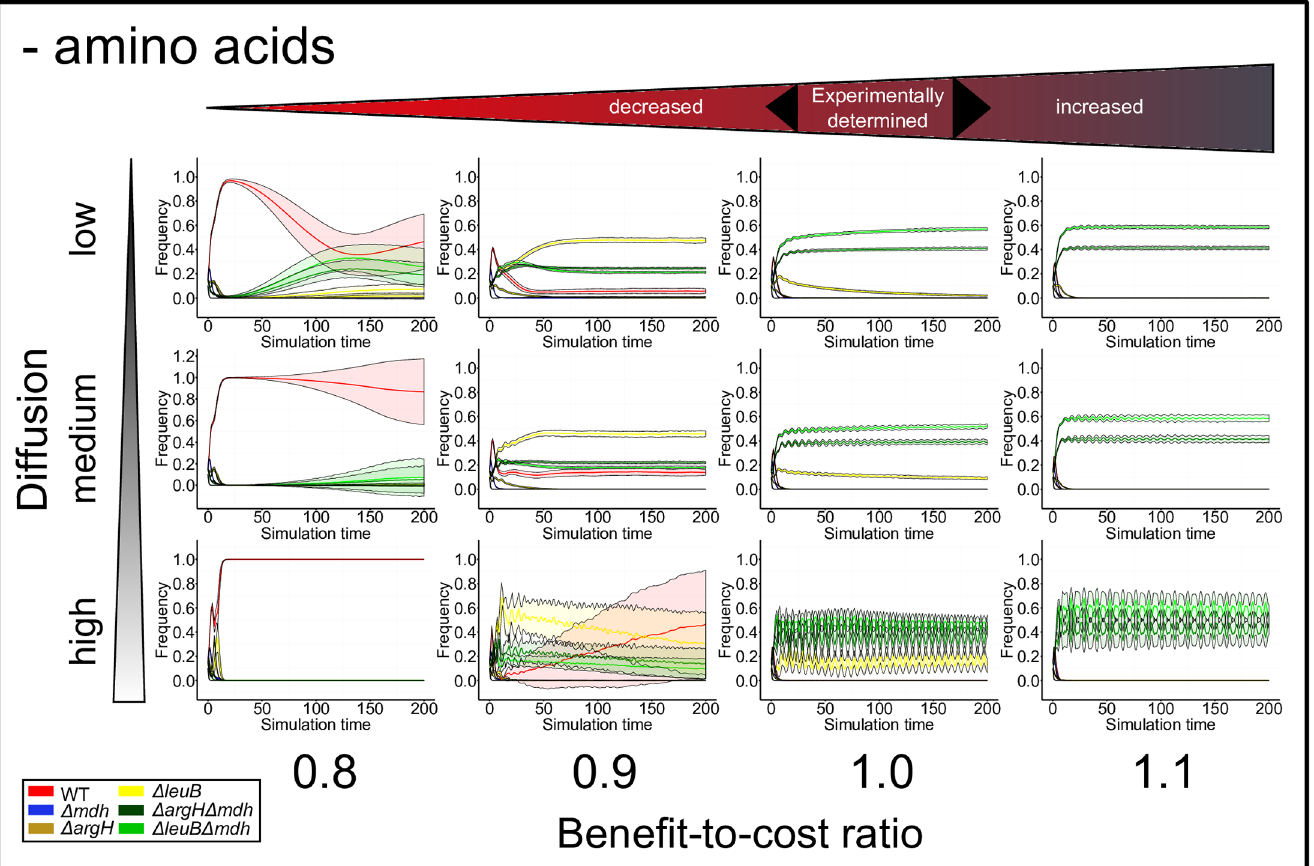
Fig 5. Population dynamics in environments without amino acid supplementation. Repeated simulations (n = 100) are plotted for varying benefit-to- cost ratios (BCR) and degrees of amino acid diffusion (bold line: mean, shaded ribbon: standard deviation). All simulations start with a random distribution of all genotypes and undergo a specific dynamic alternation of genotype frequencies. Depending on the genotype ’ s strategy, it can repress, facilitate, or even outcompete others (see text for more details). Legend: red = wild type, blue = overproducing genotype, yellow = auxotroph (2 types), green = cross- feeder (2